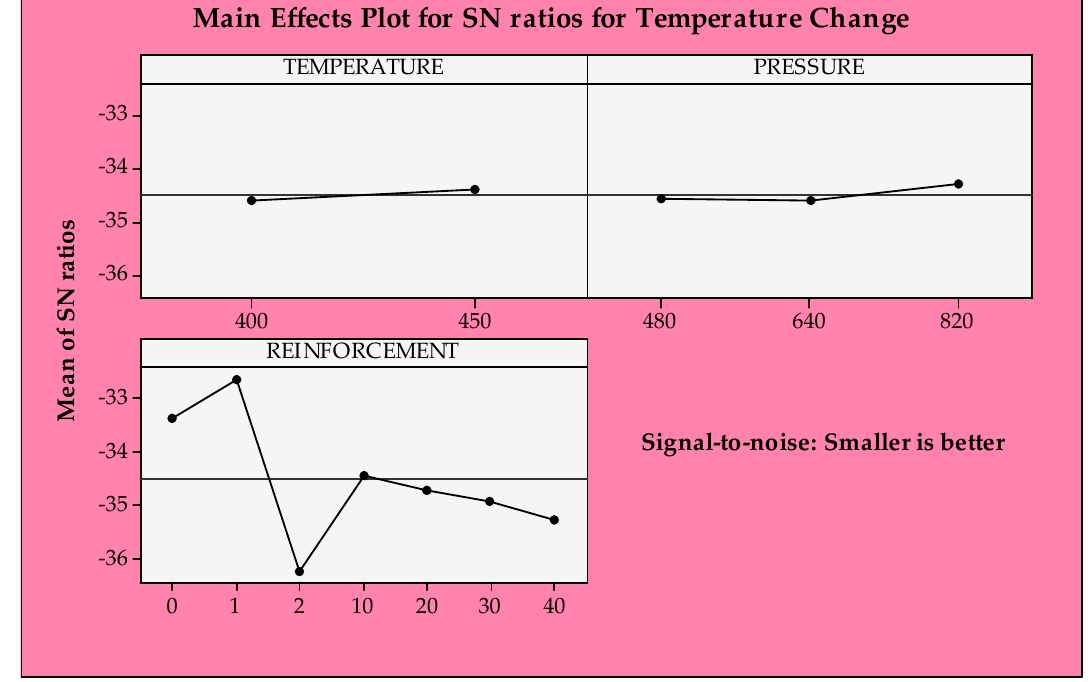
Figure 10. S/N ratios of temperature change.